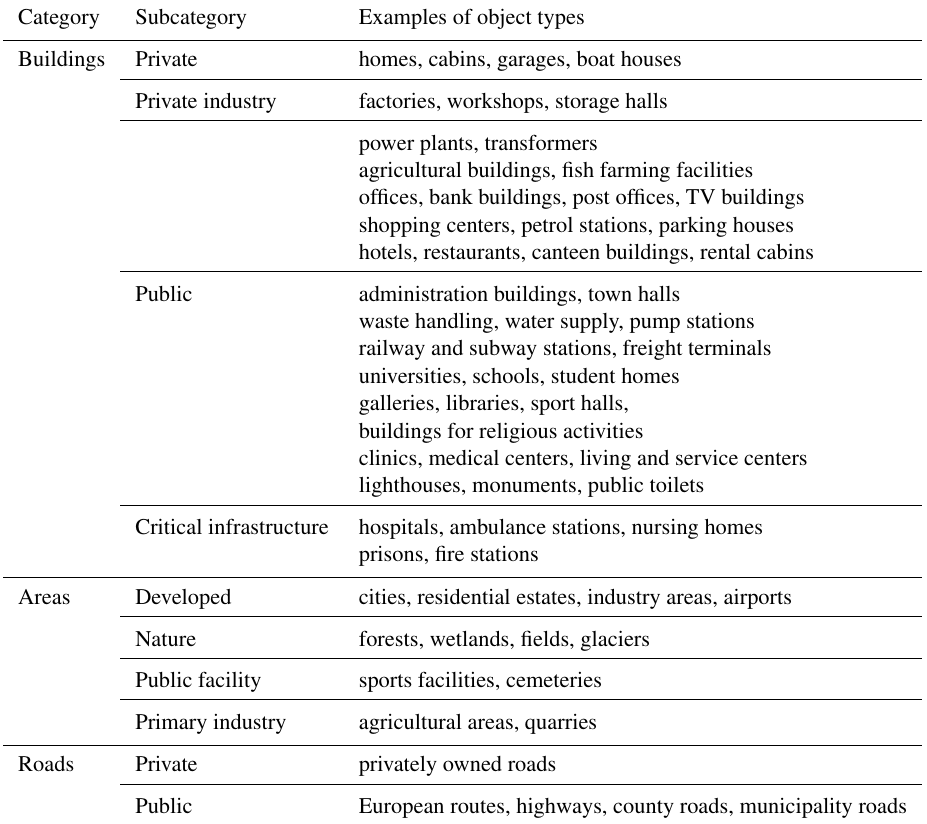
Figure 8. The bars indicate the size of areas (a) , the number of buildings (b) , and the length of roads (c) affected by sea level rise and storm surge in Norway. For each water level, the left and right bars indicate affected objects at present and for 2090, respectively. Percentages on top of the right-hand bars indicate total change from now to 2090 due to sea level rise. Table 1. Overview of categories and subcategories of objects potentially exposed to coastal